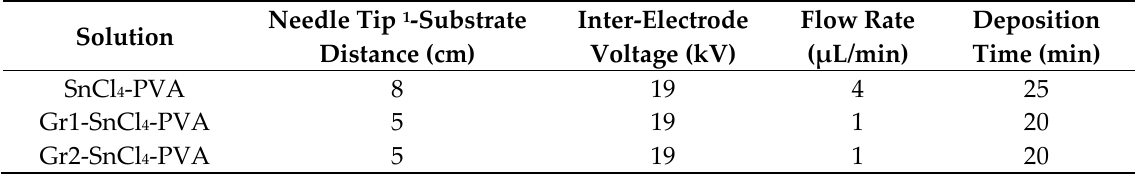
Table 1. Summary of the electrospinning conditions.